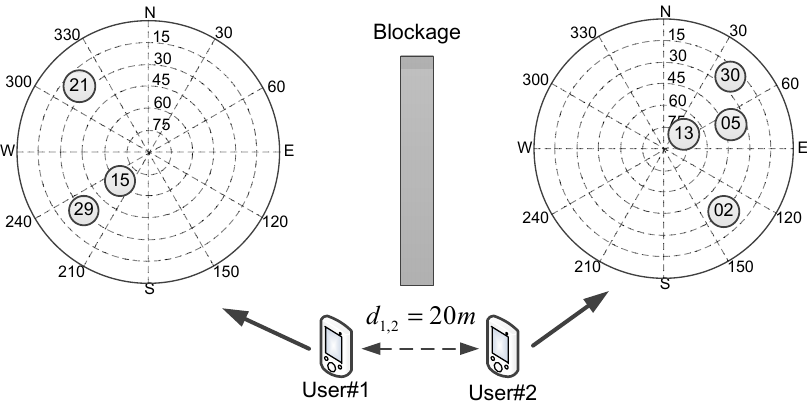
Figure 4. User distribution and skyplot of the blockage simulation scenario.